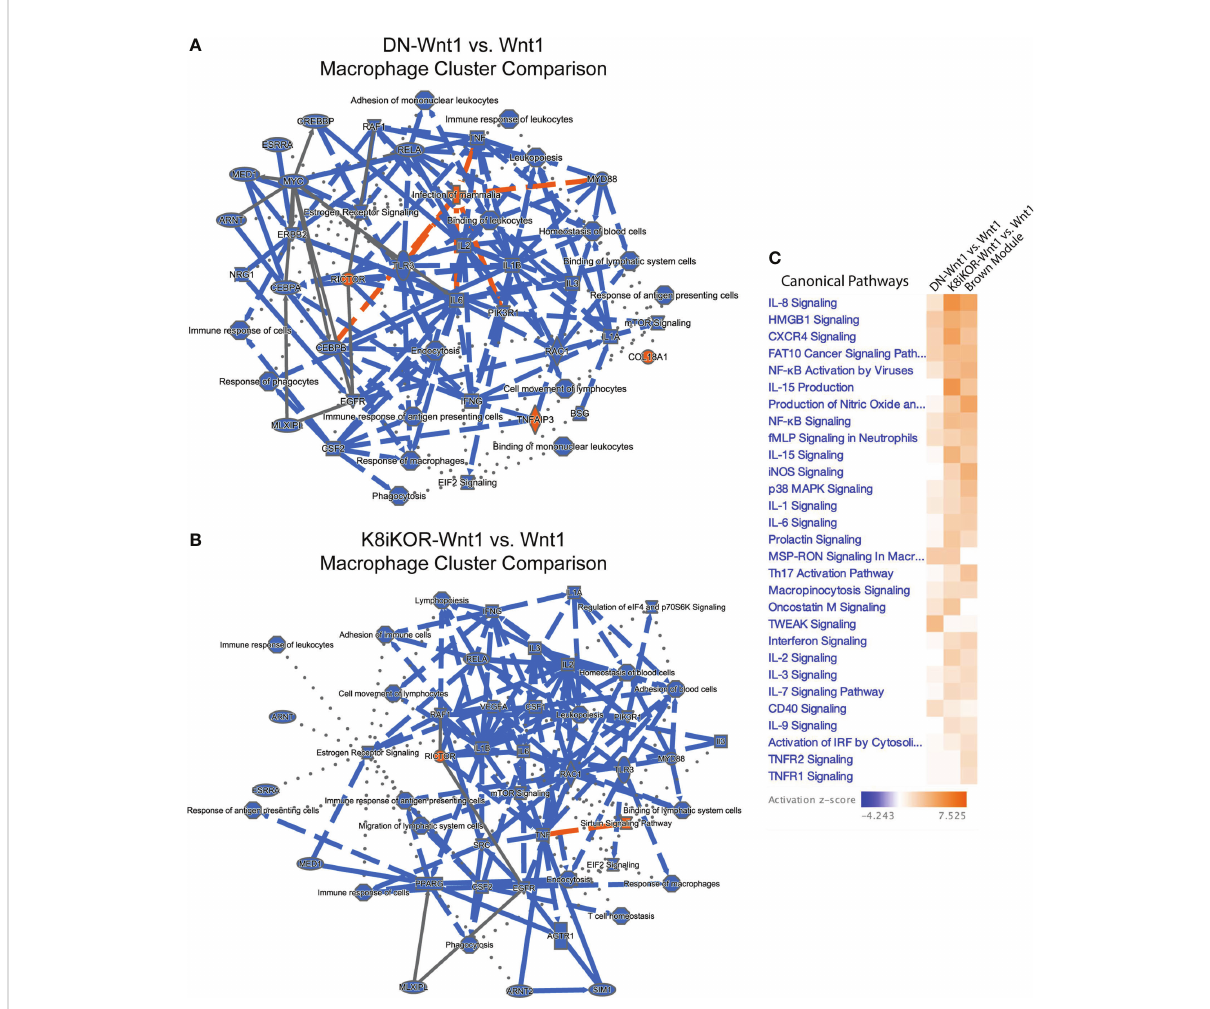
FIGURE 4 (A, B) Macrophage and immune signaling pathways are altered with reduced IGF1R. IPA graphical summary of top pathway alterations in DN- Wnt1 (A) or K8iKOR-Wnt1 (B) compared to Wnt1 tumors from Cluster 2 (MACs). Blue=downregulated; orange=upregulated. (C) IPA canonical pathways heat map of DN-Wnt1 and K8iKOR-Wnt1 compared to Wnt1 tumors and the METABRIC brown (immune signaling signature)